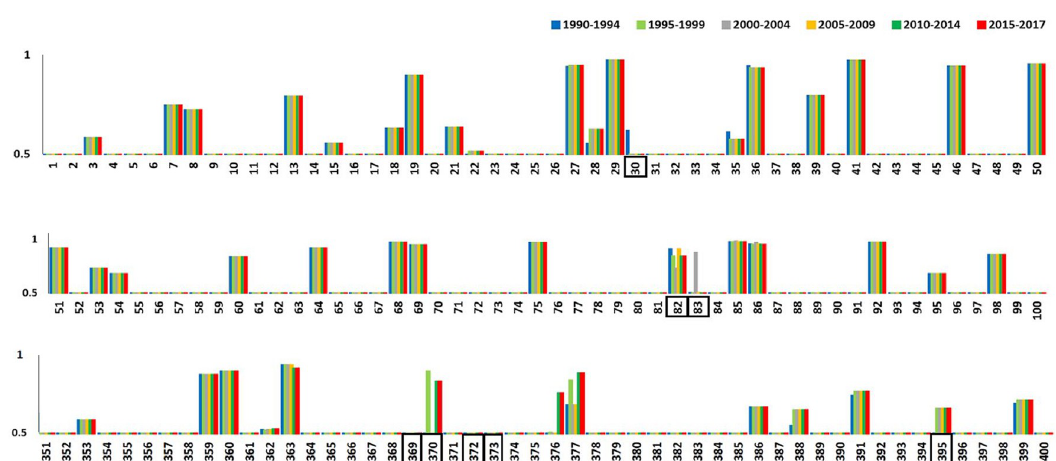
Fig 5. Proteasomal degradation sites in HIV-1 CRF01_AE gag protein. Proteasomal degradation sites gag protein sequences from 1990–1994 (blue), 1995–1999 (light green), 2000–2004 (grey), 2005–2009 (yellow), 2010–2014 (dark green), and 2015–2017 (red) year groups were predicted using NetChop software. Below the sequence, the numbers indicating the position of each amino acid with reference to the HXB2 reference strain are shown. Only proteasomal degradation sites with a cut-off value > 0.5 are shown. The black box indicates the position at which the mutation